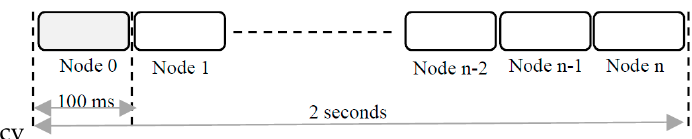
Figure 6. TDMA mechanism used for network scan.